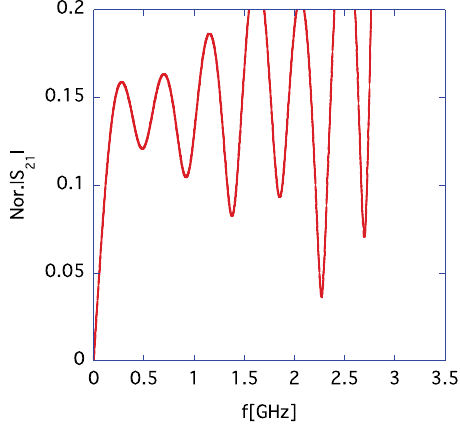
FIG. 24. Measured S 21 after the TDG treatment for the exponential electrodes without